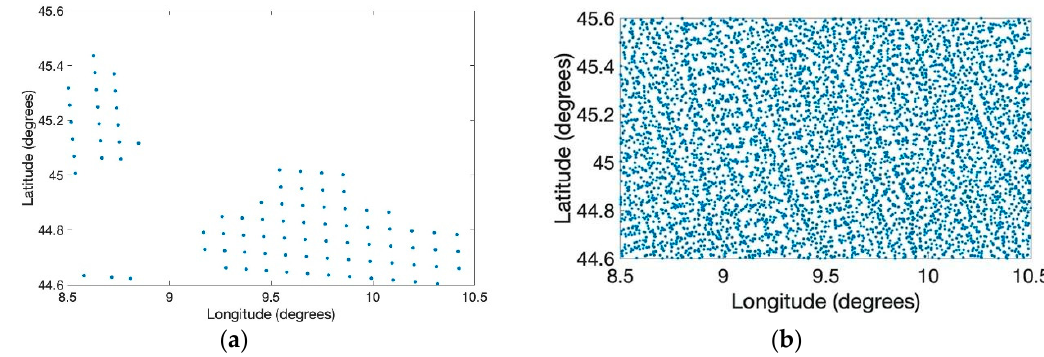
Figure 3. Clear sky Tropospheric Monitoring Instrument (TROPOMI) satellite footprints (whose centers are shown with a dot) for one single overpass ( a ) and after one month of overpasses ( b ). After kriging operation, the data are labeled as Level 3, in contrast to the original (Level 2) sparse